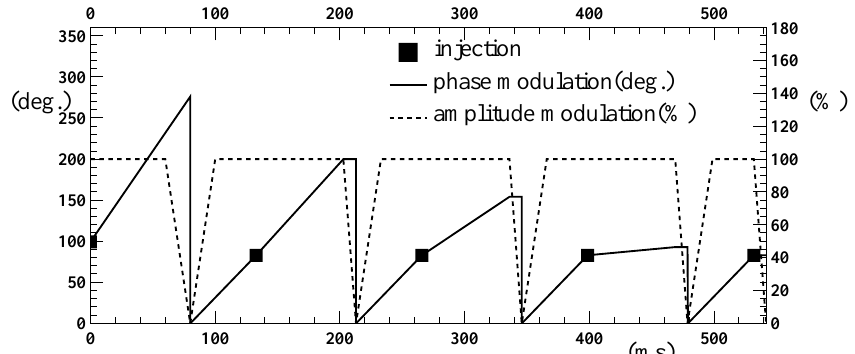
FIG. 9. Phase and amplitude modulation patterns for a moving barrier. The horizontal axis is the time from the first injection. The vertical axes are degree (left) and % (right). The solid and dotted line are phase-modulation and amplitude-modulation pat- terns, respectively. The solid squares show the timings of injections. The phase of 0 ± corresponds to that of the fixed